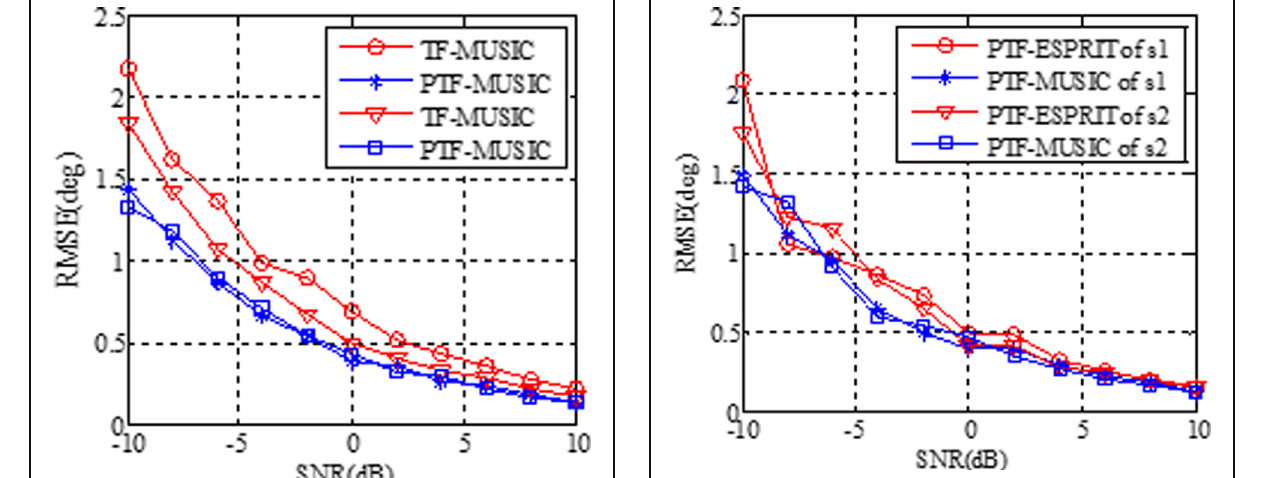
Fig. 6 RMSE of two PTF DOA estimation